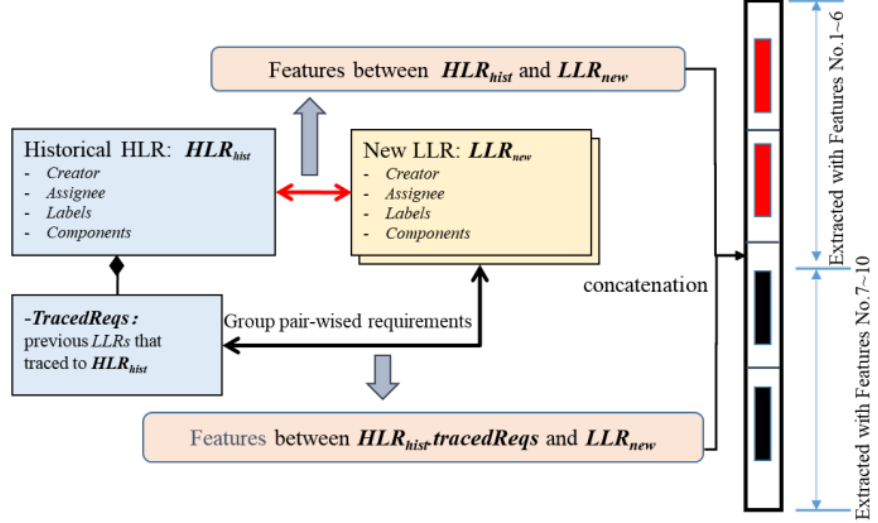
Figure 6. Extract extended features based on the historical trace list.